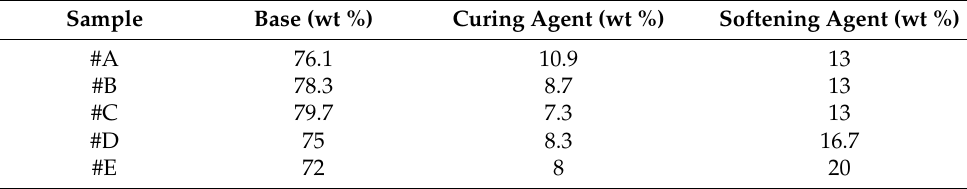
Table 1. Combination ratios of PDMS samples.